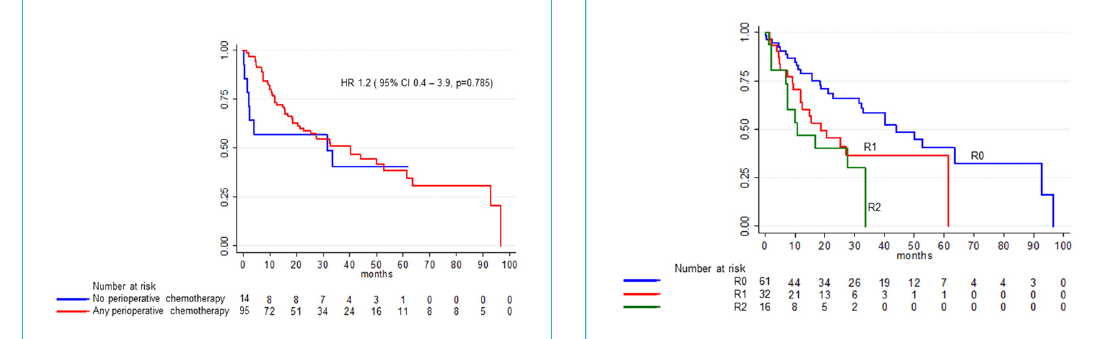
Figure 4: Overall survival according to resection status. Medi- an overall survival in patients with R0 resection was 52.7 months (IQR 8.9 months – not reached), whereas survival for those pa- tients with R1 resection was 20.5 months (IQR 6.3 months – not reached), and for patients with R2 resection status 10.7 months (IQR 5.9 months – not reached). R0 is associated with improved survival; R1 vs R0: HR 9.4 (95% CI 1.1–79.2; p = 0.040); R2 vs R0: HR 8.6 (95% CI 0.9–79.2; p = 0.057); R1 vs R2: HR 0.95 (95% CI 0.4–2.4; p =